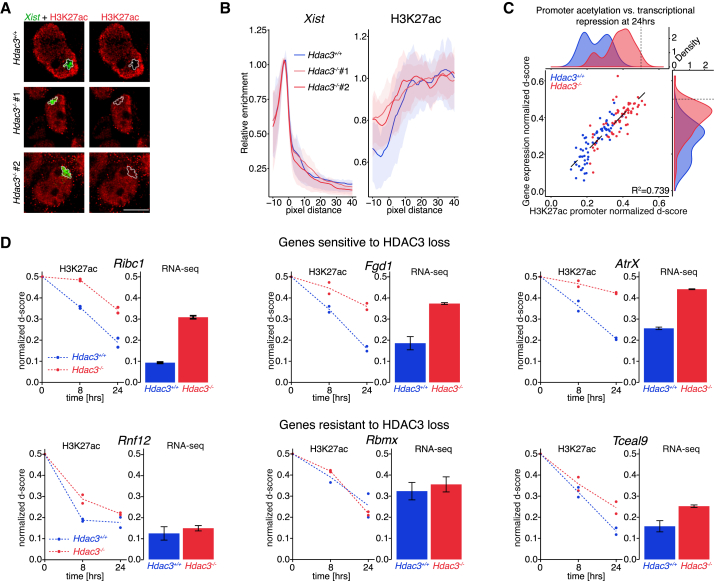
HDAC3 Promotes Silencing by Rapidly Deacetylating Histones(A) IF/RNA FISH on TX1072 (Hdac3+/+) and two Hdac3−/− ESC clones induced with DOX for 24 hr. Cells were probed using anti-H3K27ac (red) antibodies and a Xist intronic probe (green). The white dotted line encircles the Xist domain. Because of technical variability, contrast settings were individually adjusted to reflect relative enrichment. Scale bar, 10 μm.(B) Quantification of (A) over at least 100 Xist clouds. Shown is the average signal for Xist and H3K27ac when profiles were aligned to the Xist cloud boundary (for more details, refer to Figure S4A and D).(C) Relationship between gene repression (RNA-seq) and promoter deacetylation (H3K27ac) at 24 hr in TX1072 (Hdac3+/+, blue) and Hdac3−/− (red). On the scatterplot, the black dotted line represents fitted linear regression. ρ = 0.860. Density plots show the distribution of the normalized d-score for H3K27ac (horizontal) and RNA-seq (vertical); note that d-scores in mutant cells are shifted toward biallelic levels (0.5, dotted lines on density plots). Each dot represents the average normalized d-score from biological duplicates.(D) Comparison of promoter deacetylation dynamics and transcriptional silencing after 24 hr of DOX treatment in TX1072 (Hdac3+/+) and Hdac3−/− ESCs. Examples of genes sensitive (top) and more resistant (bottom) to HDAC3 loss are shown. For RNA-seq, shown is the average from biological duplicates (± SD).See also Figure S4.